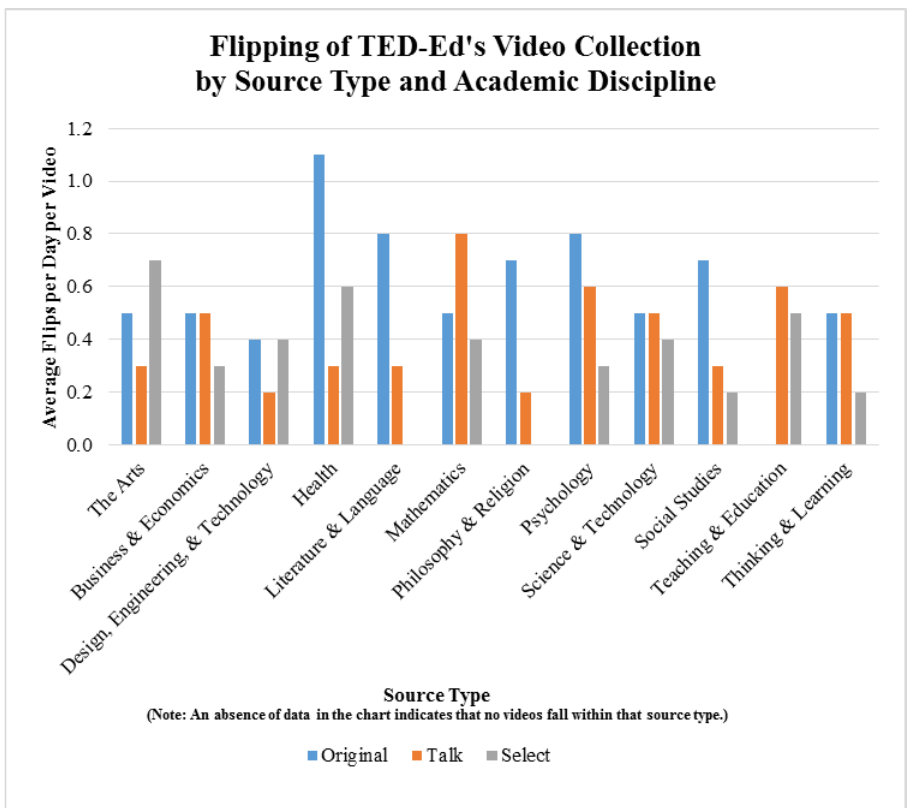
Figure 10 . Flipping by source type and academic